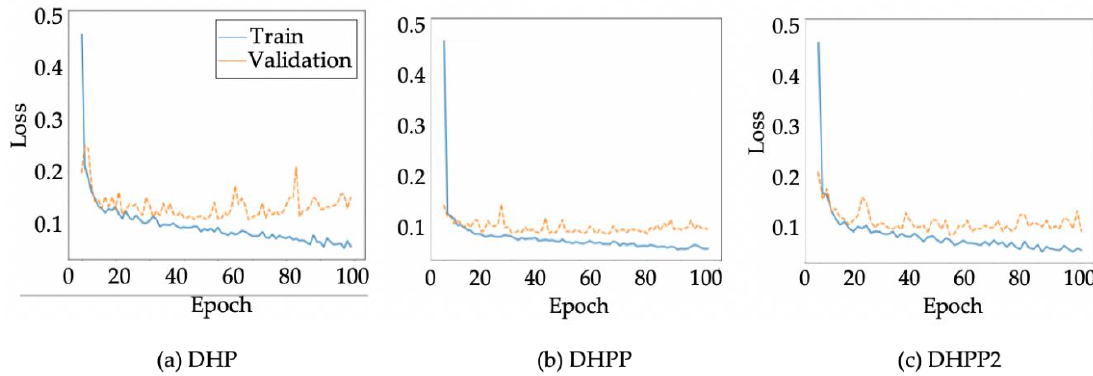
Figure 5. Training and validation loss functions for each DNN model: The model learning curves